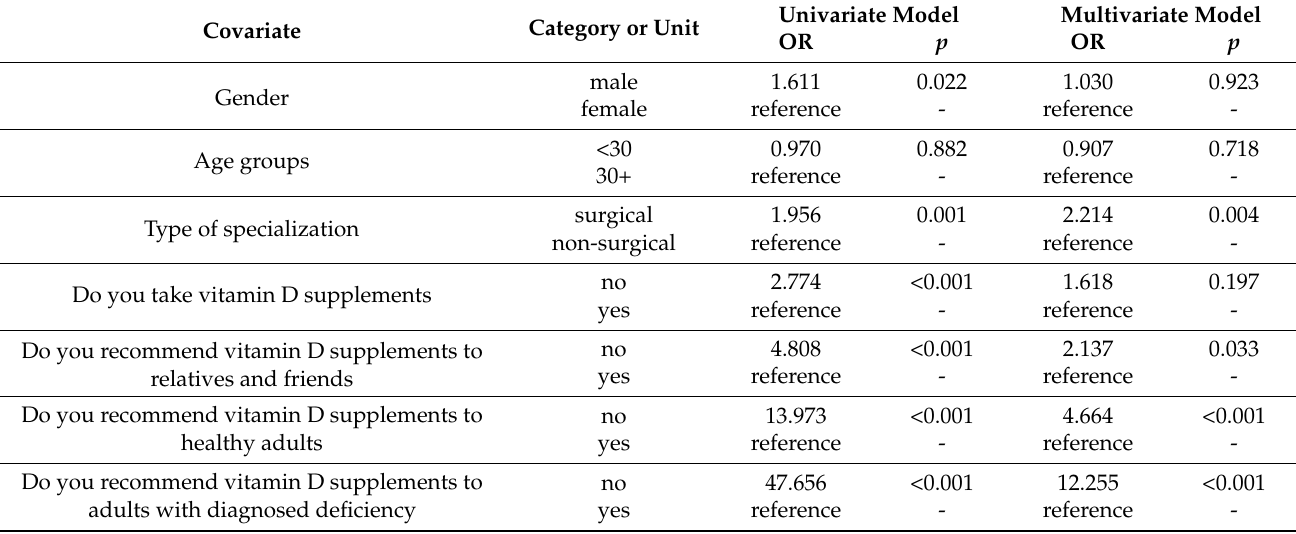
Table 6. Logistic regression analysis of not recommending vitamin D supplements to